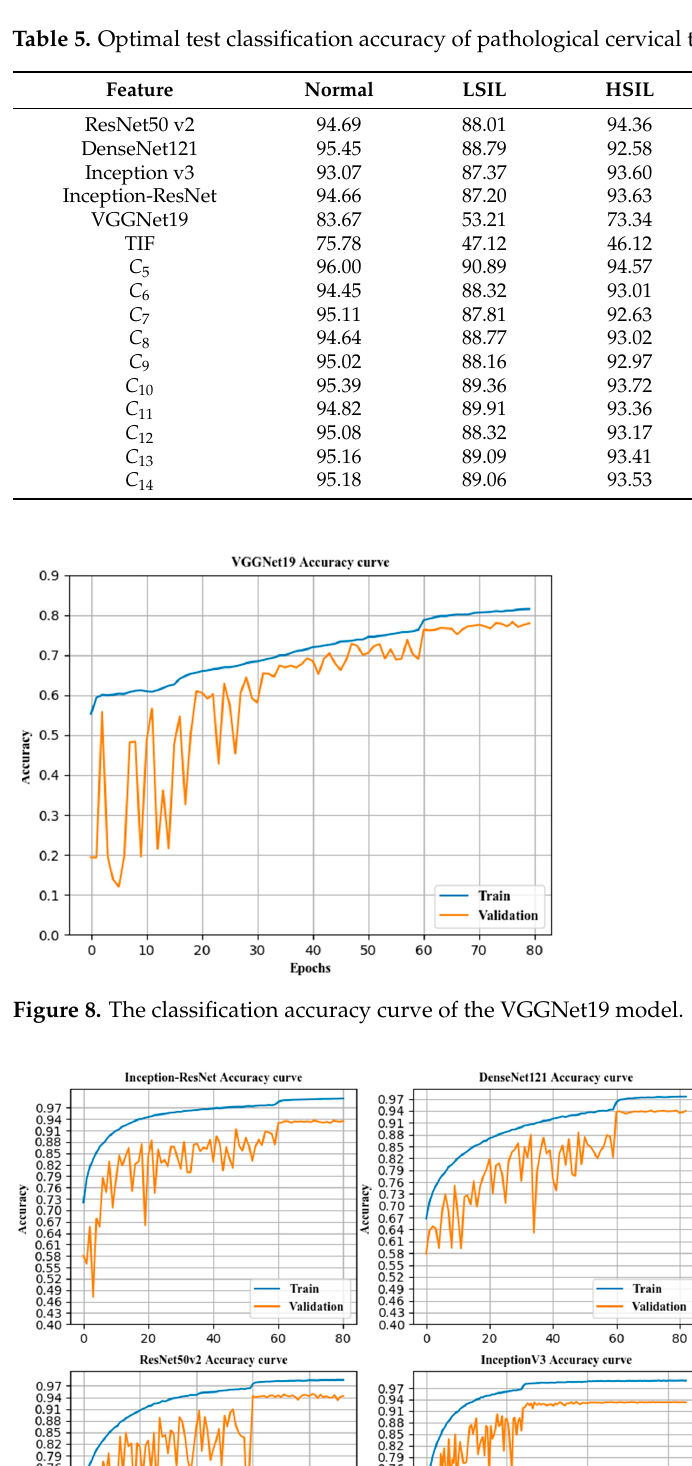
Figure 10. The classification accuracy curves of the fused models. 3.4. Model Evaluation The ROC curve was used to evaluate the single models, the combined models, and the VGGNet19 model. The evaluation effects are shown in Figure 11, and the Area Under Curve (AUC) value of each model is shown in Table 6. Since the micro-ROC and micro-AUC values were used as the evaluation indicators for the models, the number of images after data enhancement reached 100,000, and the test sample had more than 17,000 images. The gaps between the ROC curves of the models were not particularly large, most of the curves had only slight differences between them, and the drawing effect was not good. This paper combined the convolutional features of